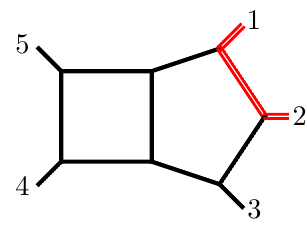
Figure 4 . The pentagon-box sector with the master integrals I 1 , I 2 and I 3